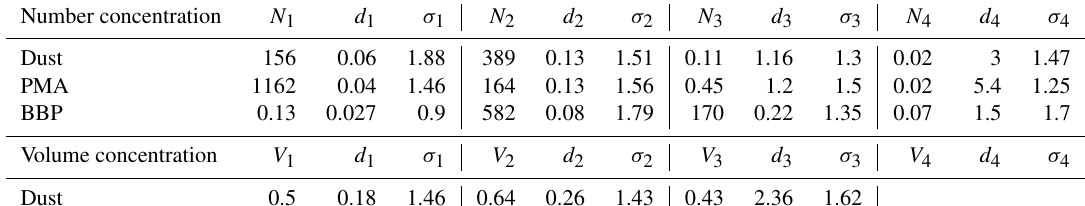
Table 3. Characteristics of the fit by a log-normal distribution ( N , d , σ ) for the three periods: dust, PMA and BBP Number concentration